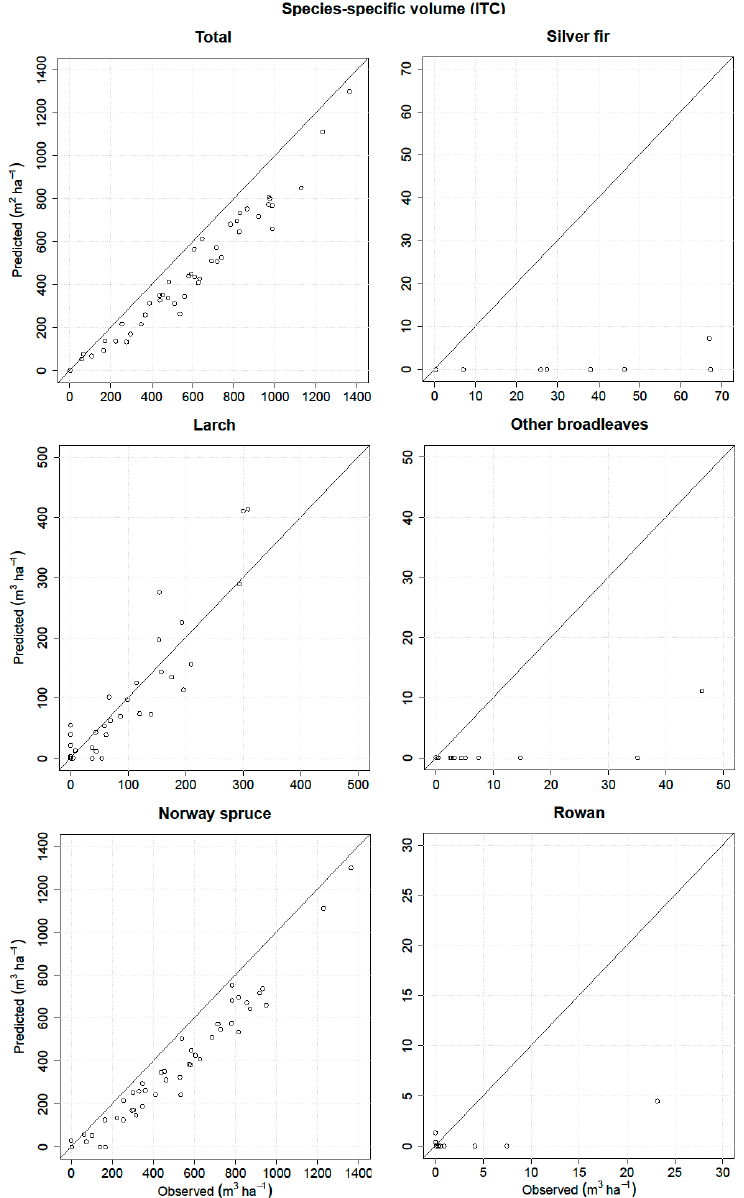
Figure 3. Observed versus predicted total and species-specific volumes at the plot level derived from the individual tree crown (ITC) method.